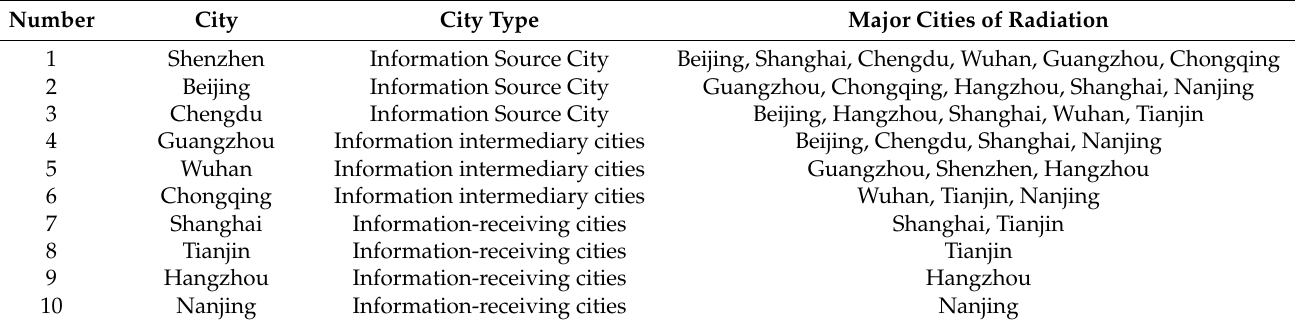
Table 7. Characteristics of urban real estate market information spillover